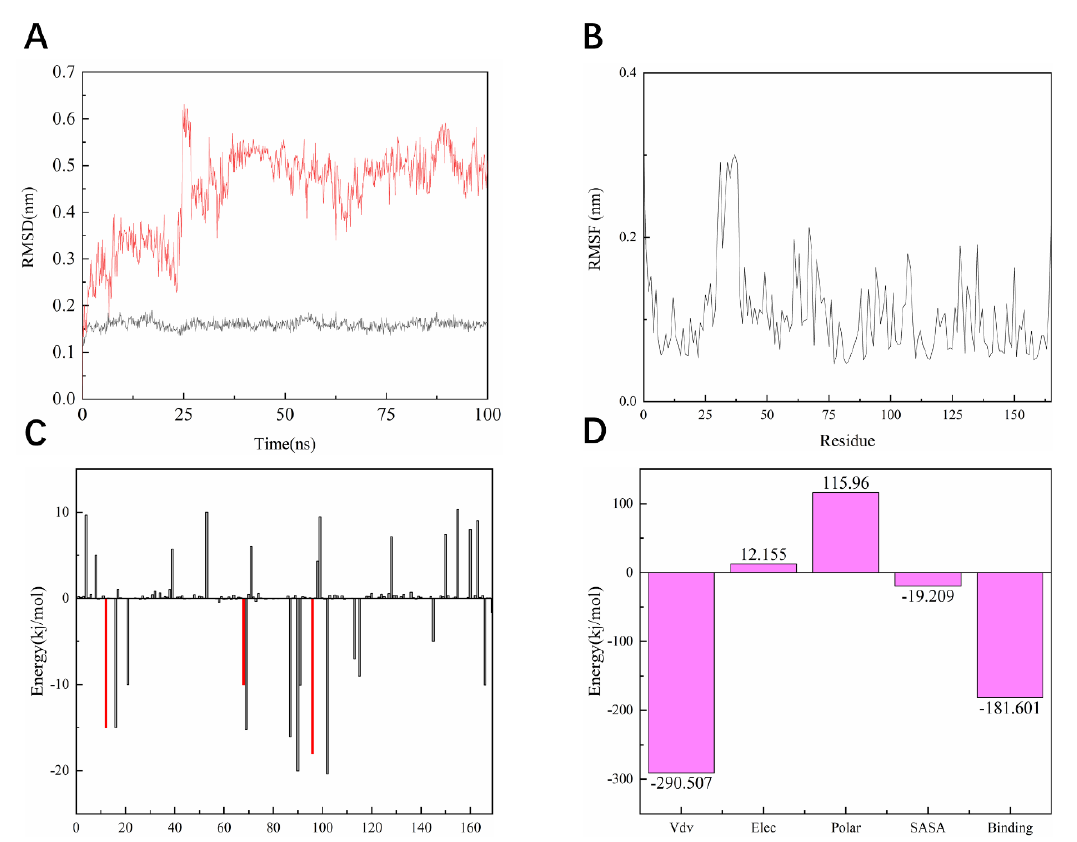
Figure 10. Dynamic simulation results. ( A ) RMSD values extracted from protein fit ligand of the protein-ligand docked complexes and ligand. RMSD plot of KRAS G12C complex (red) and ligand 44 (black). ( B ) The RMSF graph of all complexes along with the protein during 100 ns MD simulation. RMSF plot of the KRAS G12C complex (black). ( C ) Residue-wise decomposition of binding free energies obtained from the MM-PBSA analyses. Red bars indicate CYS-12, ARG-68, and TYR-96. ( D ) Binding energy of binding for the protein complexed with ligand 44.